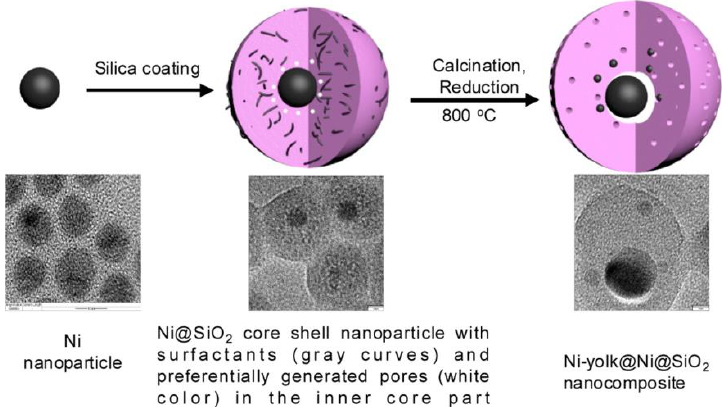
Figure 10. Schematic illustration of the formation process of Ni − yolk@Ni@SiO 2 nanocomposite. Reproduced with permission from reference [184].